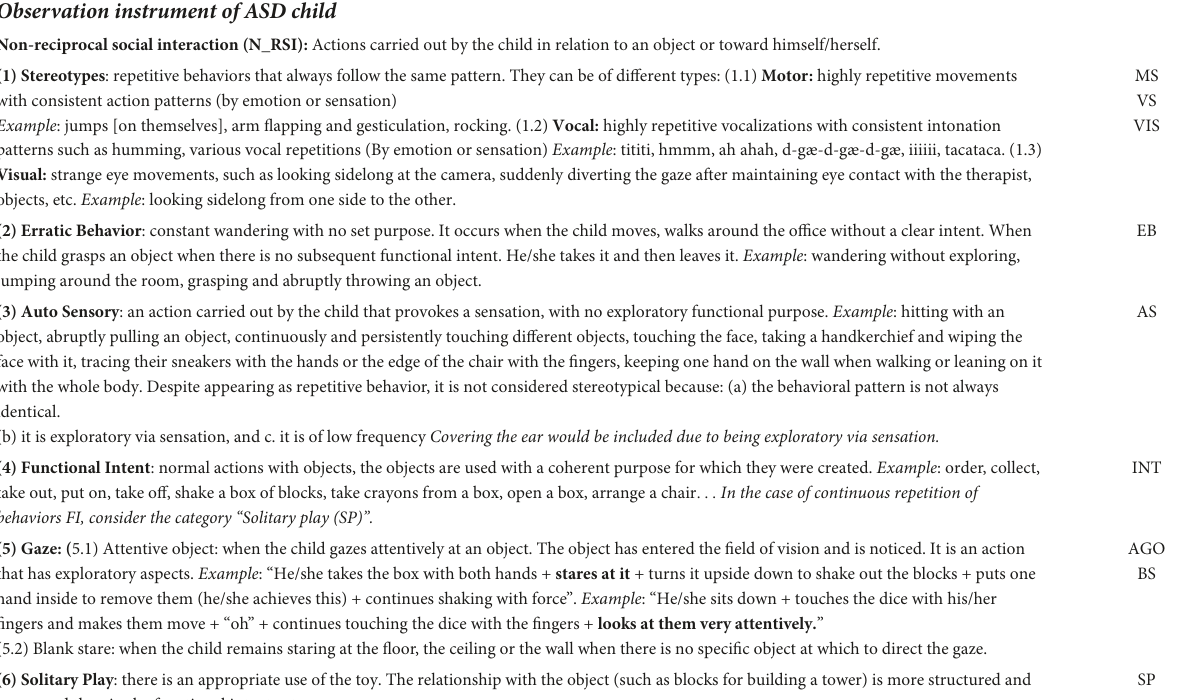
TABLE 1 Observation instrument of ASD child and psychotherapist in psychoanalytic psychotherapy. Name and definition of categories Code Observation instrument of ASD